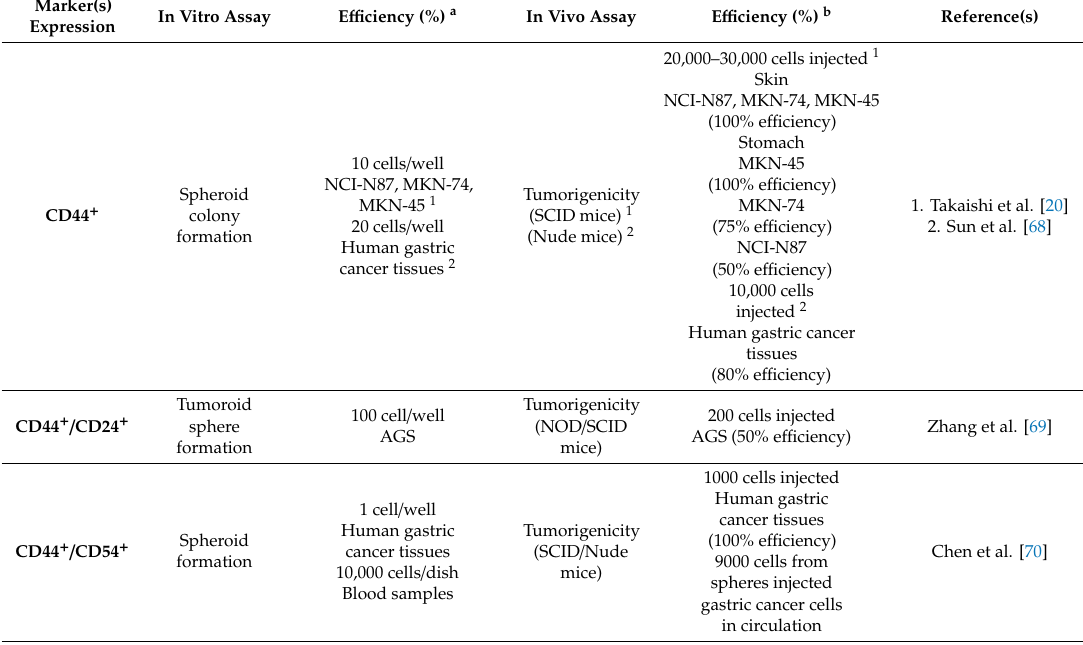
Table 2. Gastric cancer markers used to characterize gastric cancer stem